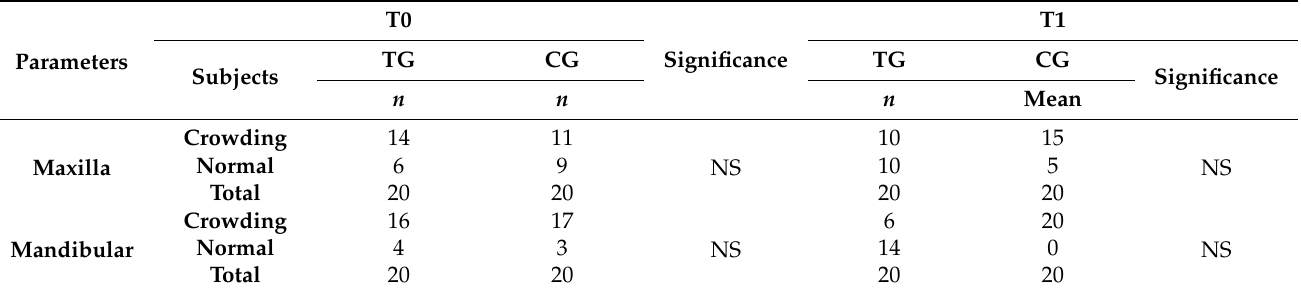
Table 2. Inferential statistics of data distribution of crowding between treatment group (TG) and control group. T0 = pre- treatment, T1 = post-treatment, SD = standard deviation, n = subjects’ number; significance set at p < 0.05 and based on chi-square